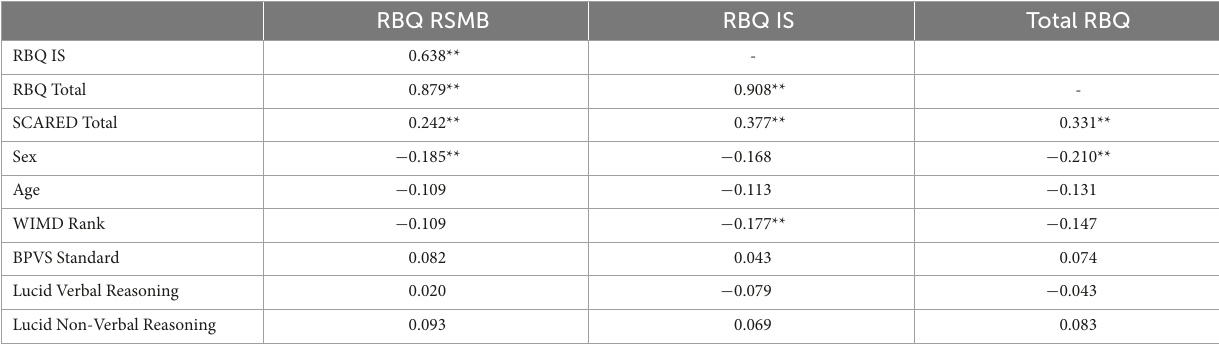
TABLE 4 Correlations between RBQ-2 and the demographic and developmental